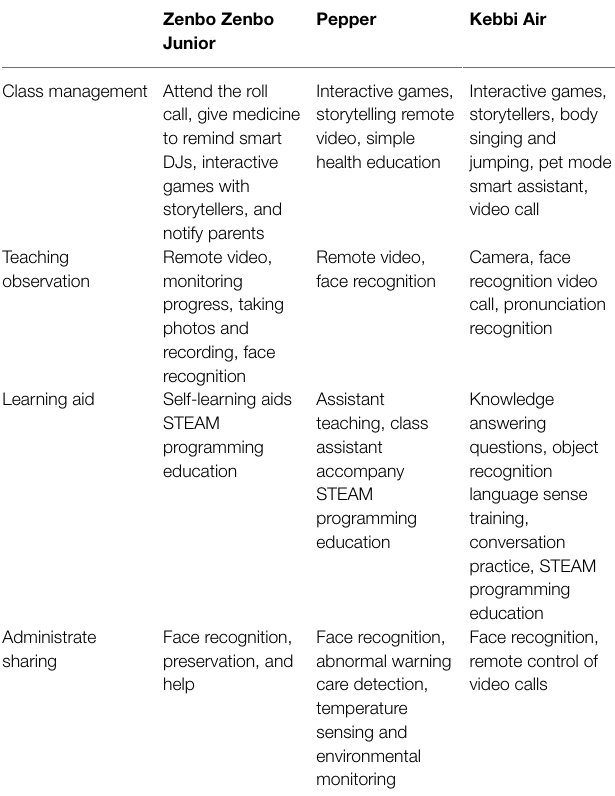
TABLE 1 | Collaborative tasks of AI technology used in school.